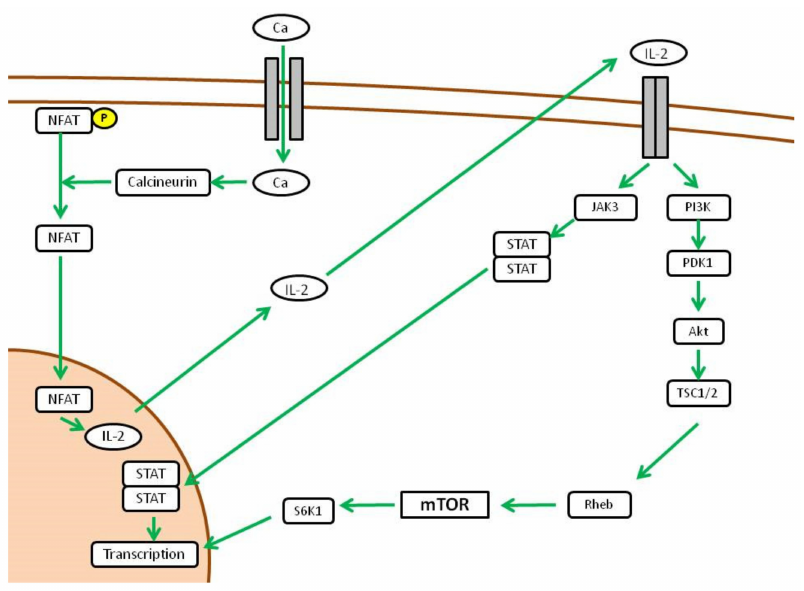
Figure 3. Downstream activity of mTOR pathway (adapted from